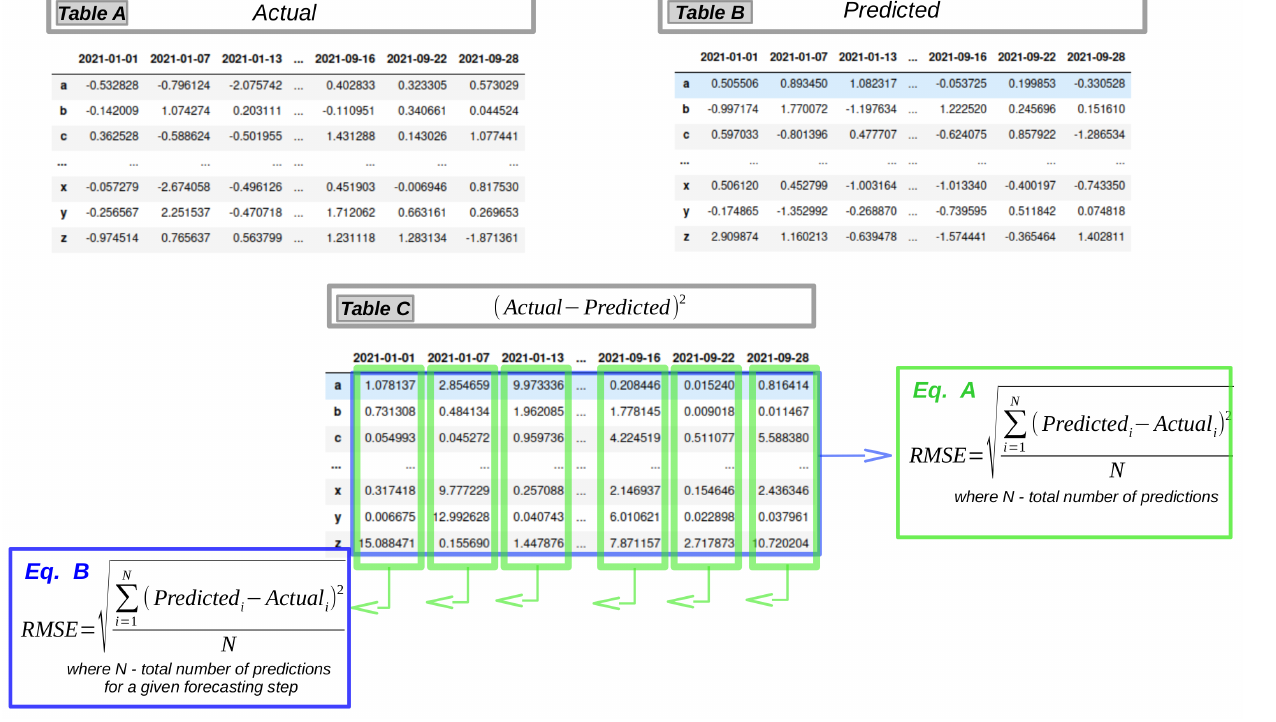
Figure 4. Schematic RMSE calculation method on the basis of synthetic data, following two ap- proaches: as a result from all observations (pattern A—on the right), as a result from the observations which belong to only one time window (pattern B—on the left). Table A contains information about the current state of data in the points (top left corner); Table B contains information with the result of machine learning predictions (top right corner); Table C provides the quadratic difference of the current state and the prediction for each point in time